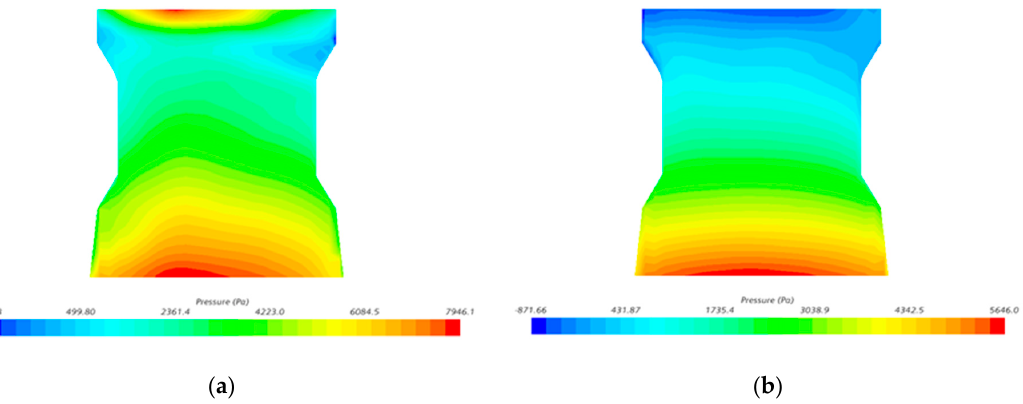
Figure 22. Horizontal distribution ( a ) and stress cloud diagram of the peak value of slamming pressure ( b ) at the top of the